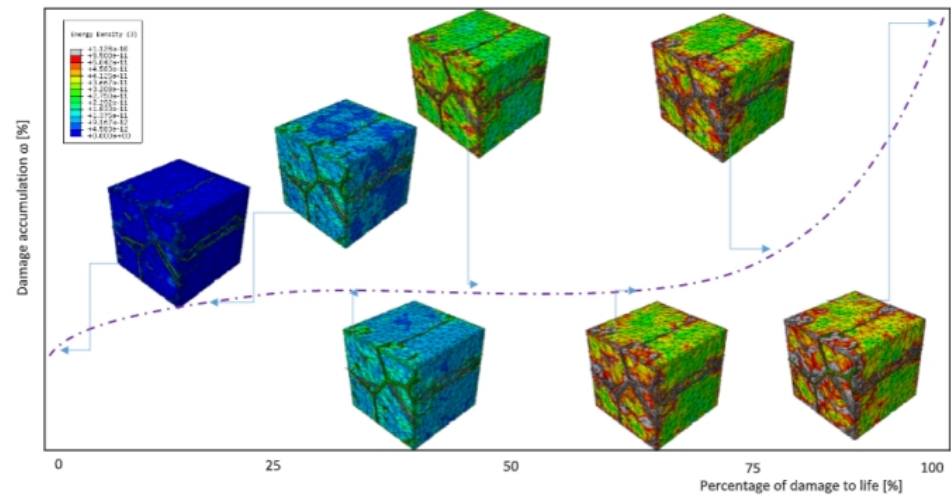
Figure 24. Damage map due to fatigue.